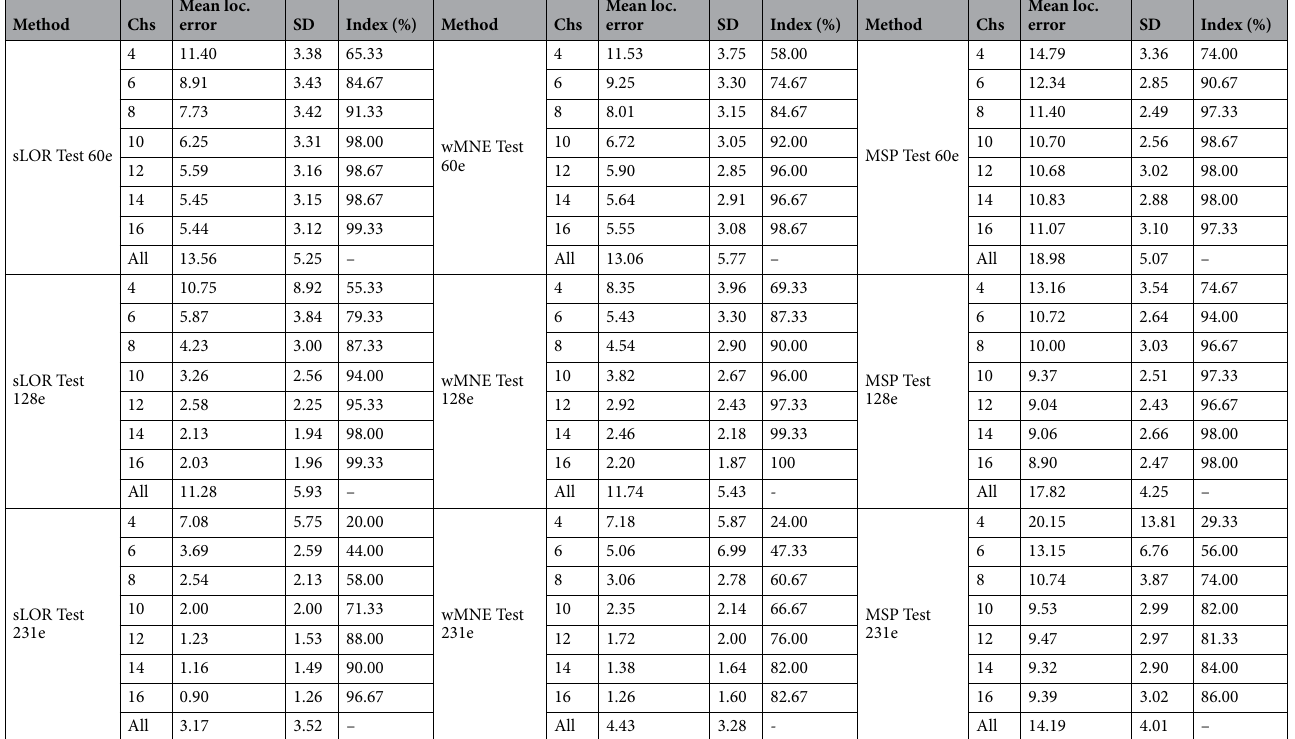
Table 2. Multiple-source test